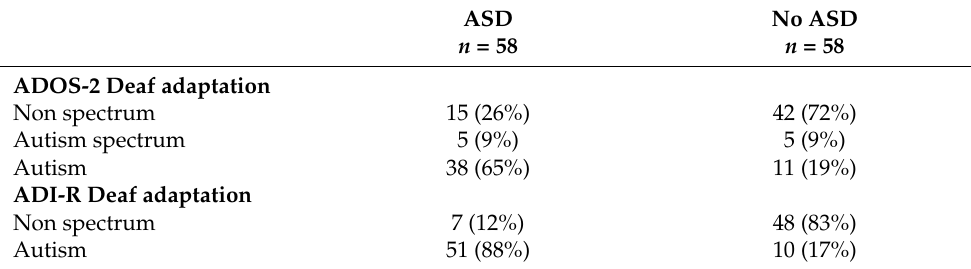
Table 3. Classification based on ADI-R Deaf adaptation and ADOS-2 Deaf adaptation thresholds by ASD diagnosis based on NICE guideline standard clinical